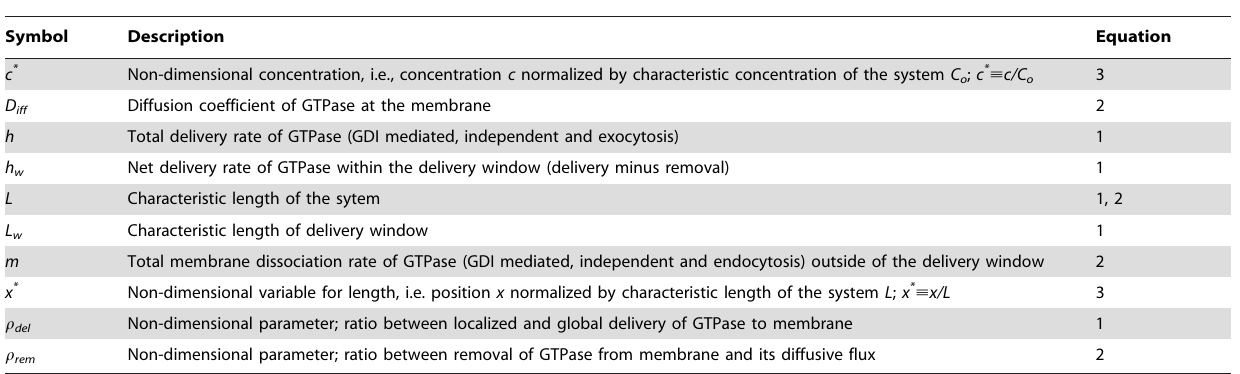
Table 1. Variables and parameters used in ‘Vesicle traffic’.